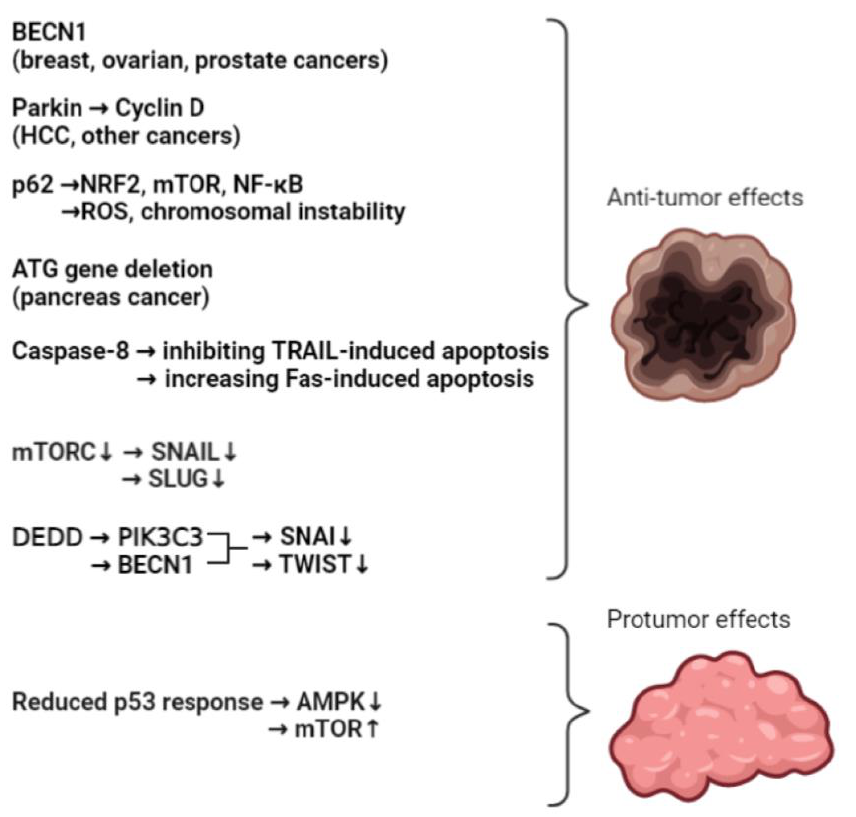
Figure 1. The complex molecular background of the influence of Janus-faced autophagy on tumors. Stated in parentheses are the cancer types in which the feature has been demonstrated. ↓ : down-regulation; ↑ : up-regulation. The figure was created partly by using BioRender.com, accessed on the 3 rd of April, 2023.